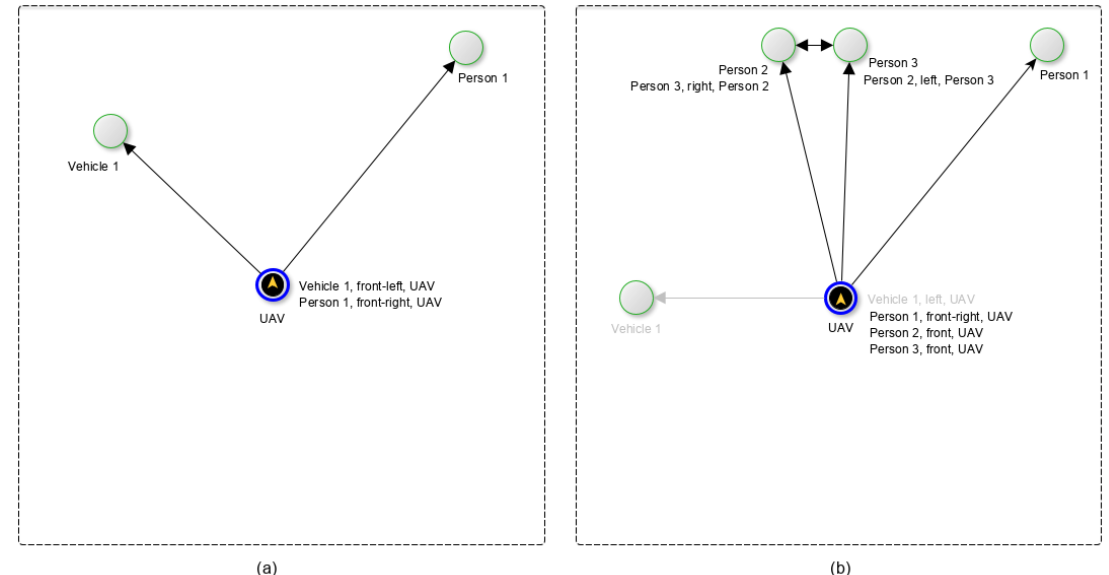
Figure 6. ( a ) A visuospatial map with information about the identified objects in the environment and their spatial relationship with the UAV. ( b ) A visuospatial map with additional spatial information about the relation between two close objects. Additionally, a graphical representation is shown of an object (vehicle 1) that is being forgotten.